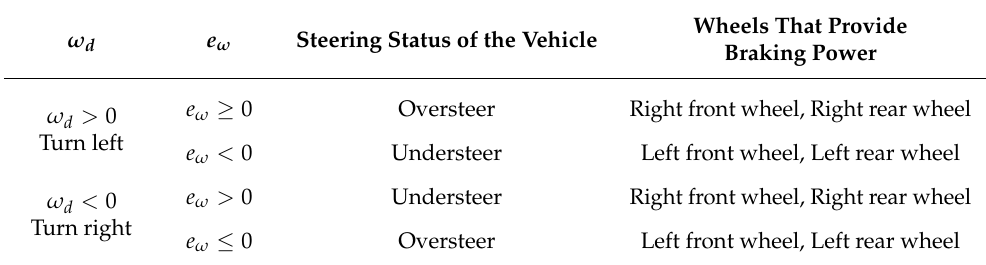
Table 11. Braking force distribution